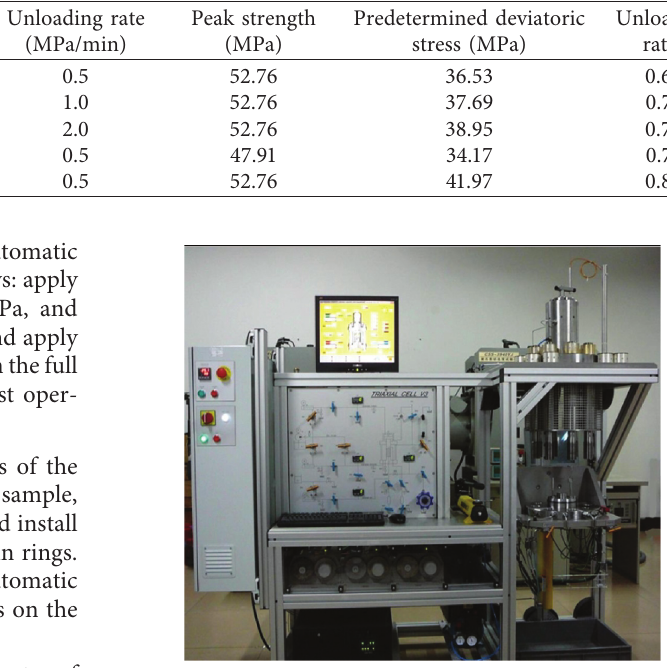
Figure 3: Automatic triaxial servo